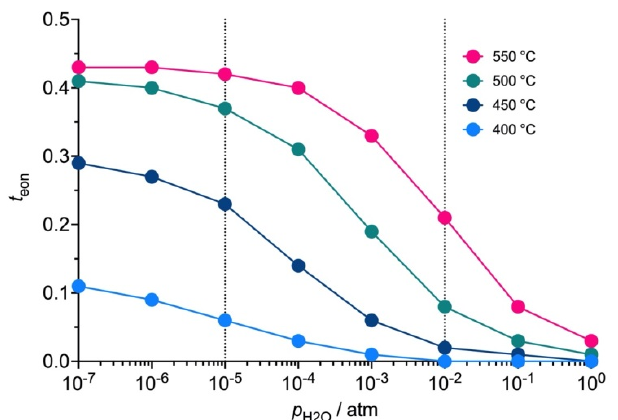
Figure 8. Electronic transport number for hole conduction of the BCY10 electrolyte as a function of water vapour partial pressure ( p H2O ) in O 2 atmosphere obtained from [24].